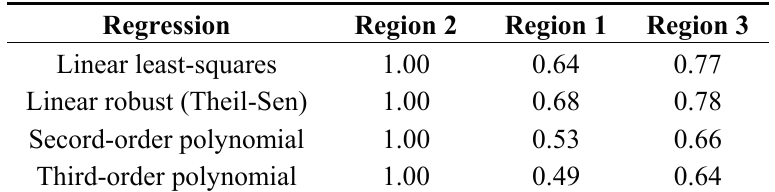
Table 4. Overall classification accuracies of See5 decision tree classification of regression coefficient by